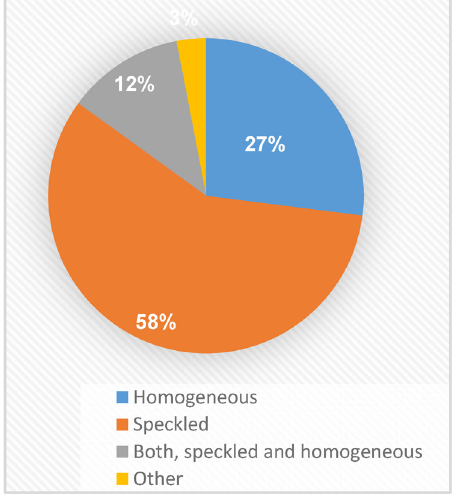
Figure 5: Distribution of antinuclear antibodies